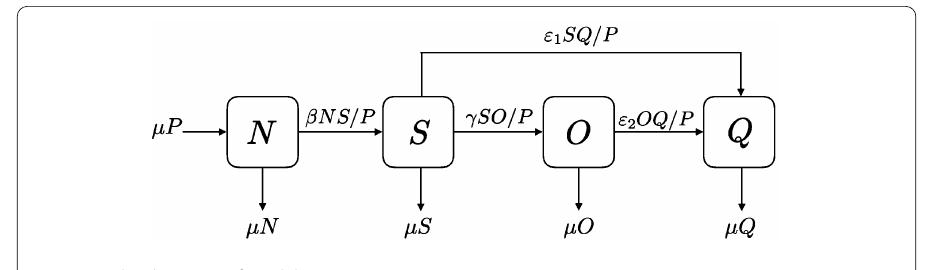
Figure 1 The dynamics of model